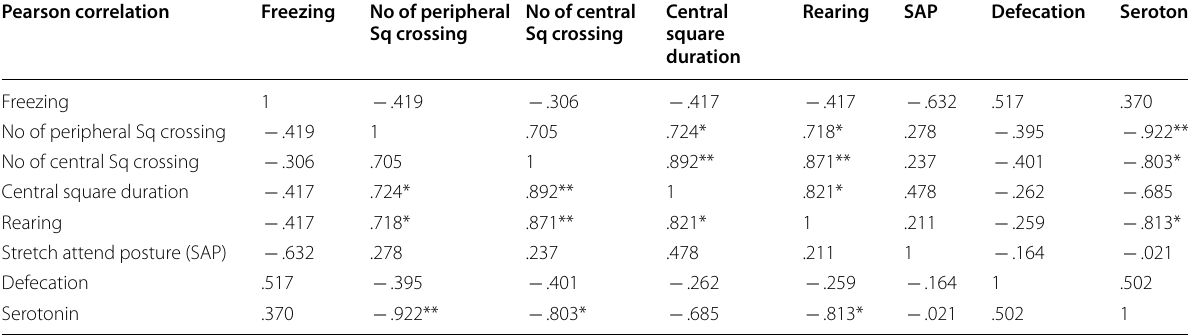
*Correlation is significant at the 0.05 level (2-tailed) **Correlation is significant at the 0.01 level (2-tailed) No number; Sq square